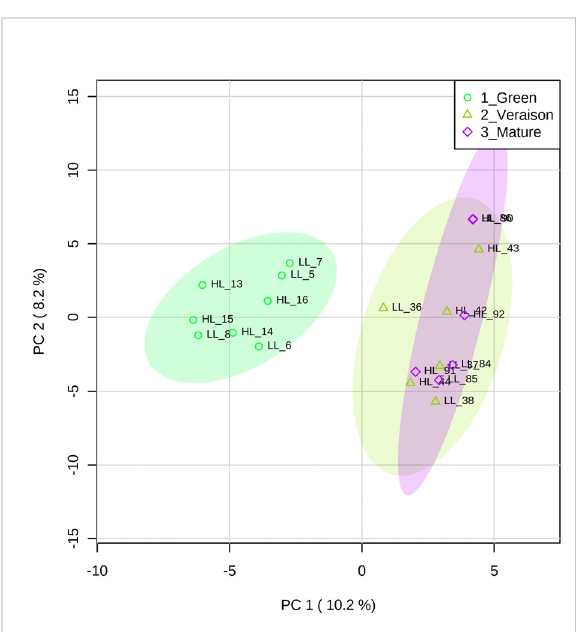
FIGURE 2 Principal component analysis (PCA) score plots of the lipidomics data for grape seeds from Alvarinho berries at three developmental stages (green, veraison, mature) and light microclimates (LL, low light; HL, high light). Colored ellipses represent 95% con fi dence interval ( n = 4 for green stage and n = 3 for veraison and mature stages). The numbers next to the LL and HL indicate the sample identi fi